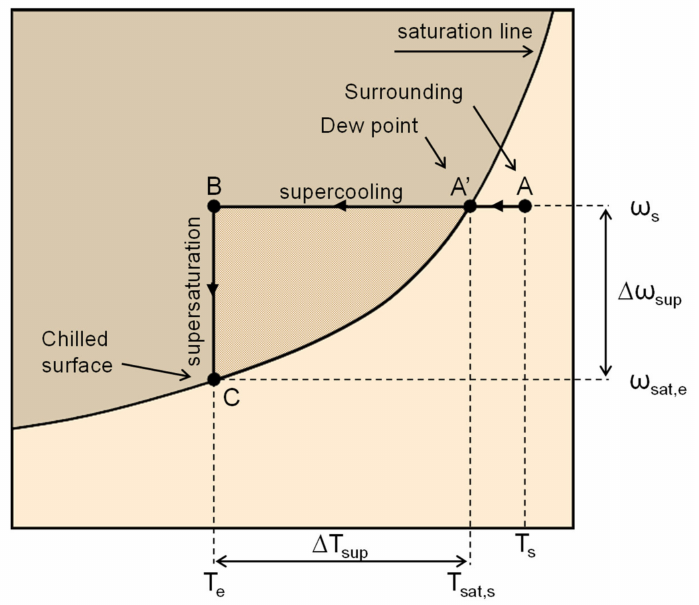
Figure 4. Representation of the metastable states during vapor desublimation on a psychrometric